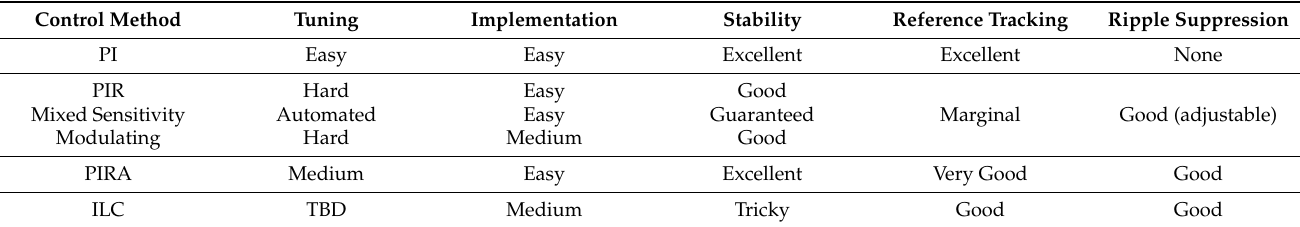
Table 1. Comparison between the different control